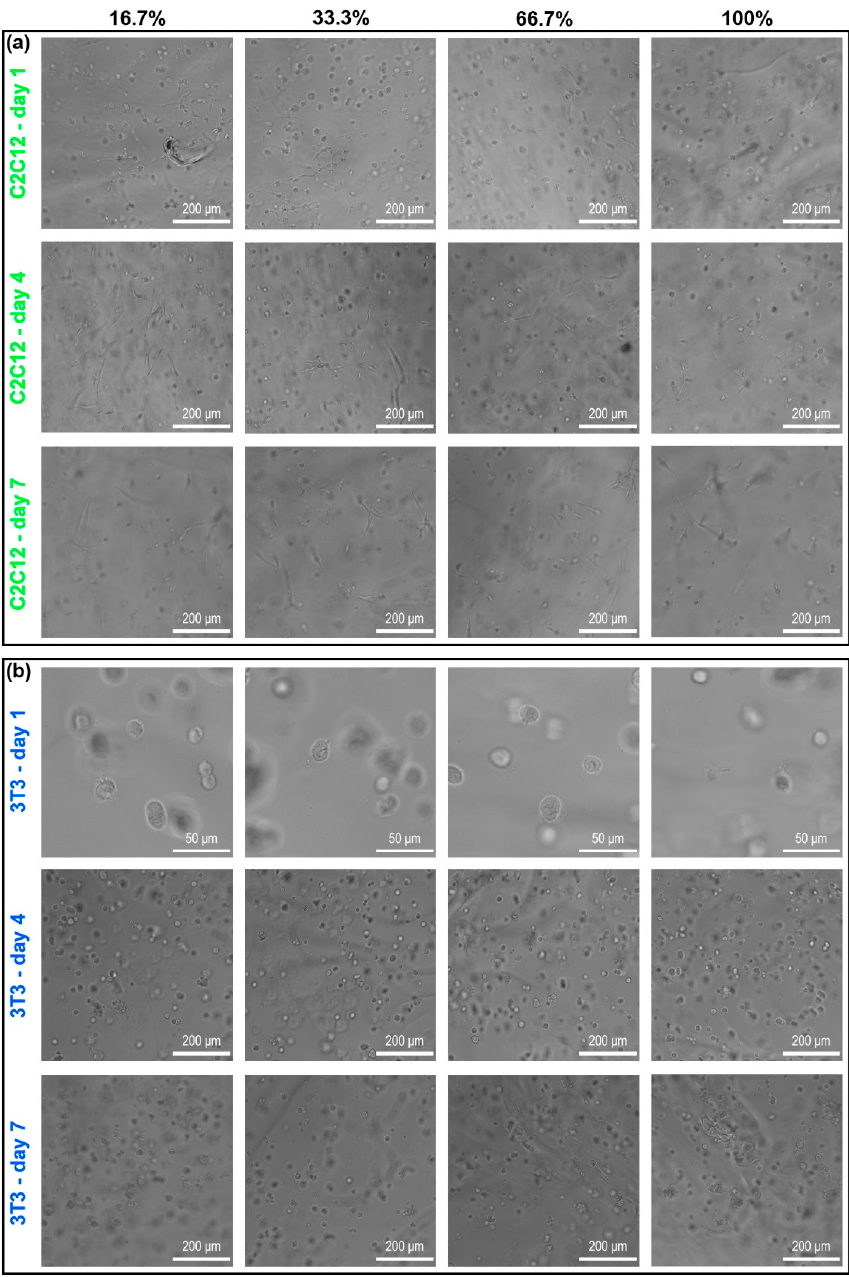
Figure 8. The images of C2C12 and 3T3 cells in four different RGD clustering cases under the bright field. The main parameters of dextran hydrogel were crosslinking strength = 2 mM and RGD = 50 µM. ( a ) C2C12 cells; ( b ) 3T3 cells. Cells were observed by an inverted microscope, and the images were taken with a digital sCMOS camera. The proportions of the mal-dextran reacted with RGD for four cases are 16.7%, 33.3%, 66.7%, and 100%, respectively.